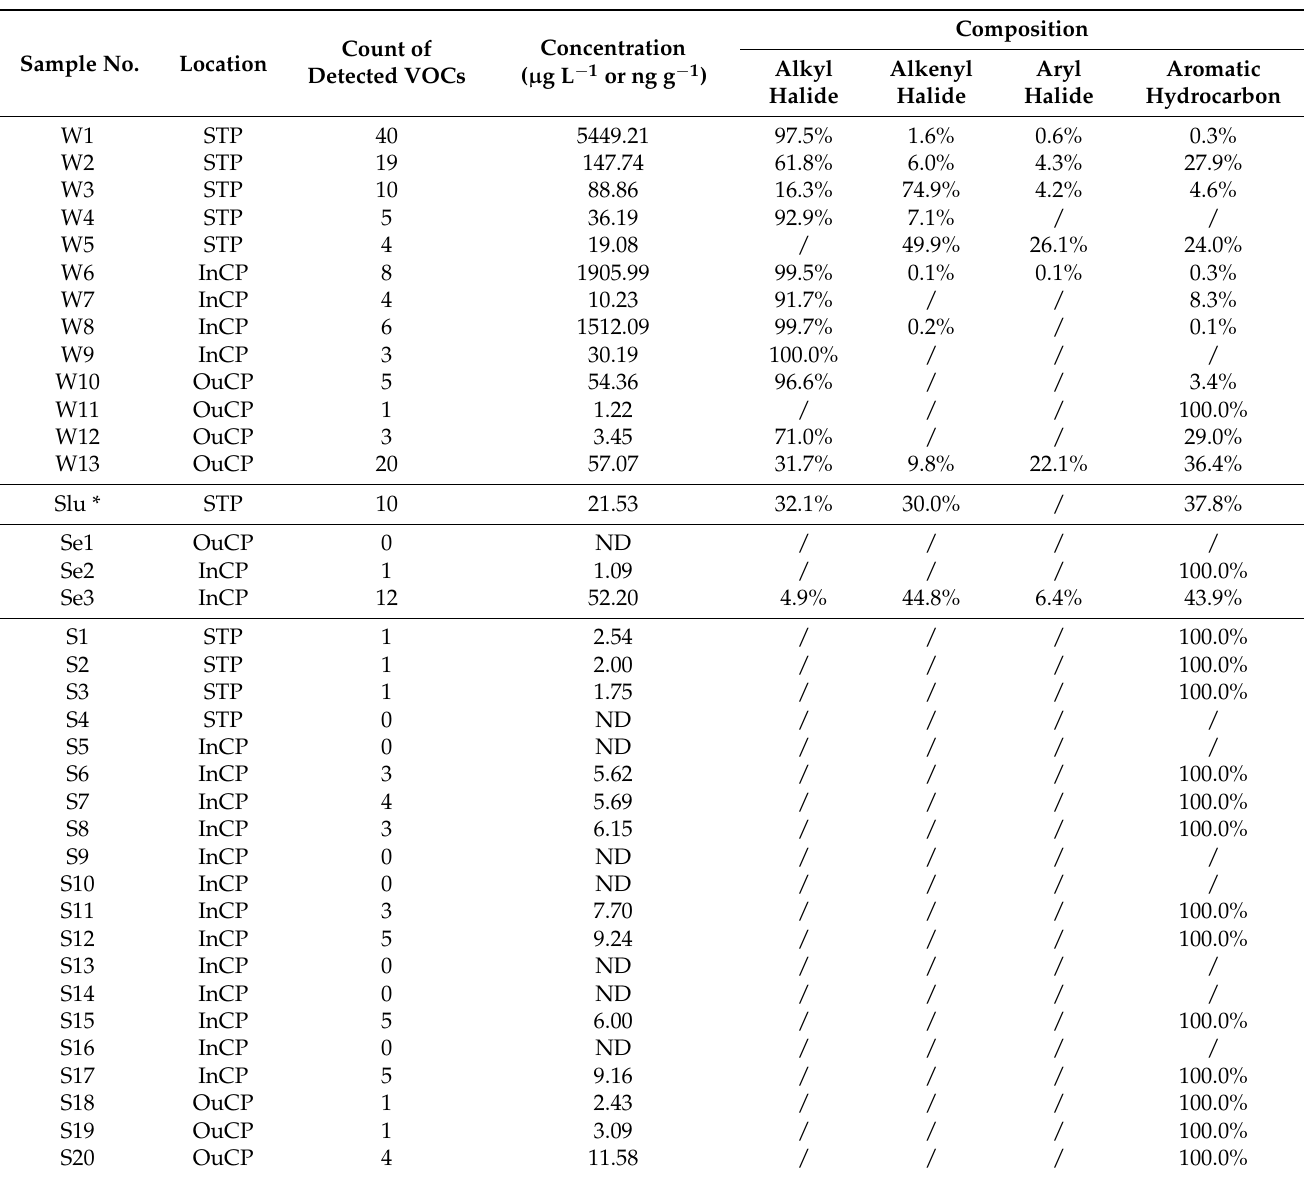
Table 1. VOCs concentrations and compositions in different samples from sewage treatment plant (STP), inside the park (InCP), and outside the park (OuCP).